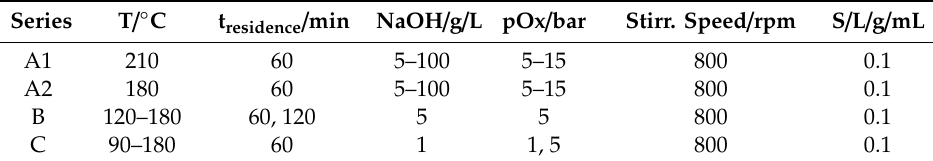
Figure 6. The mass loss at 180 °C/series A2 ( a ); the mass loss at 210 °C/series A1 ( b ); the pressure loss at 180 °C/series A2 ( c ); the pressure loss at 210 °C/series A1 ( d ); constants: 1 h, 800 rpm, S/L: 0.1. The mass losses can be partially associated with the depletion of carbon as shown in Figure 7. Particularly at 210 °C, the temperature and oxygen pressure had a considerable impact on the carbon content, which is evidence for the oxidation of carbon during leaching.